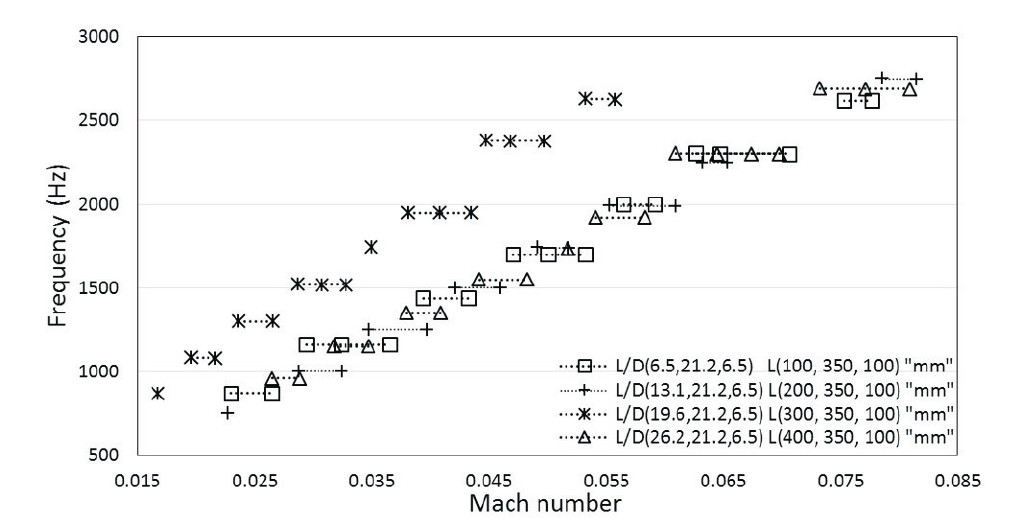
Figure 17. Frequency (Hz) plotted against Mach number M for L up = 100–400 mm, L corr = 350 mm, and L dw = 100 mm. Table 13. Mach number and corresponding frequency range (Hz) for pipe systems in Case